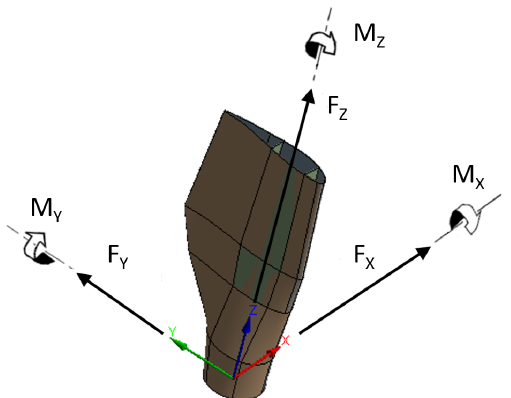
Figure 7. Blade pitch coordinate system (Germanischer Lloyd Guidelines,